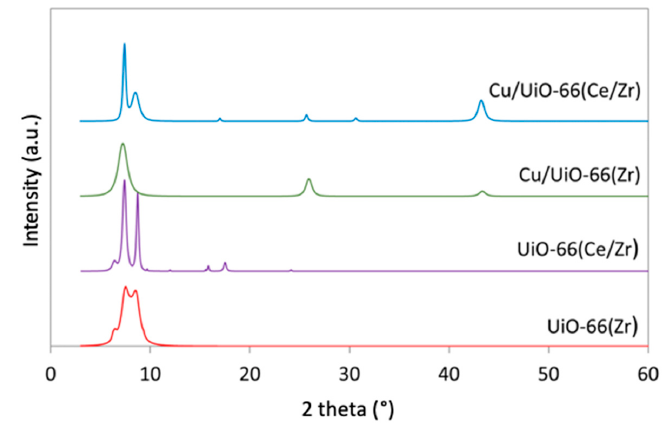
Figure 11. XRD of UiO-66 and Cu / UiO-66 materials after MeOH synthesis. Table 4. Textural properties of UiO-66 and Cu / UiO-66 after MeOH synthesis.